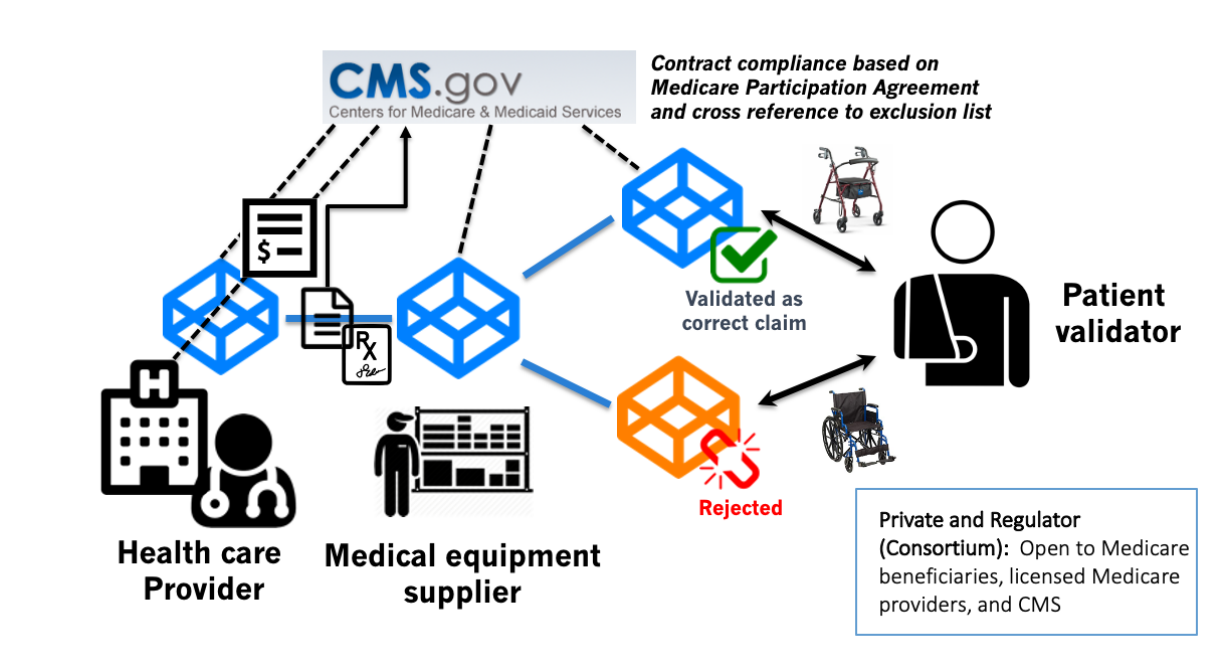
Figure 2. An example of a claim for a durable medical equipment, where a health care provider submits a claim for a walker that is supplied by a durable medical equipment provider, with the identity of the provider, durable medical equipment provider, and patient beneficiary validated by CMS. The claim is then either validated or rejected based on whether the patient actually receives the correct medical equipment. In this example, CMS was billed for a wheelchair, but the patient received a walker and validated that the claim was incorrect, leading to a potential denial of claim and detection of a false claim. CMS: Centers for Medicare and Medicaid